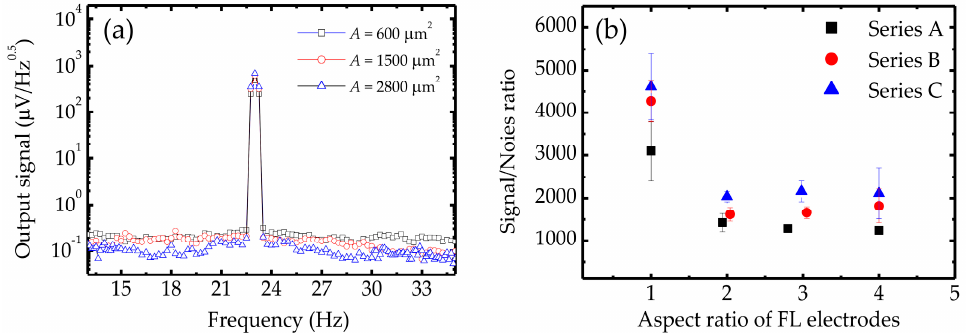
Figure 6. ( a ) Output signals from serial MTJs with same aspect ratio of free layer but different junction area A , at a bias voltage of 100 mV. ( b ) SNR ( S peak / S background ) from the detection of magnetic field of 0.3 Oe using MTJs with various dimensional characteristics. Aspect ratios of the free layer electrode ranged from 1 to 4.